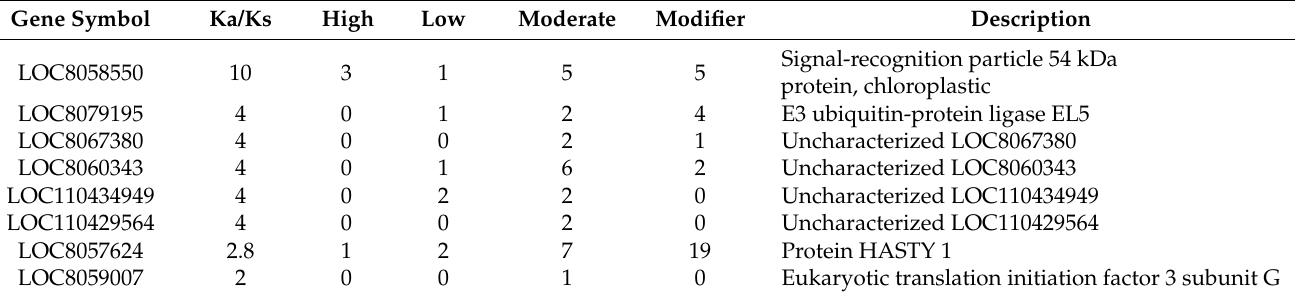
Table 2. DEGs that were simultaneously upregulated in both leaves and roots in Nampungchal compared to Sodamchal under salt stress with Ks/Ka ratios and mutational